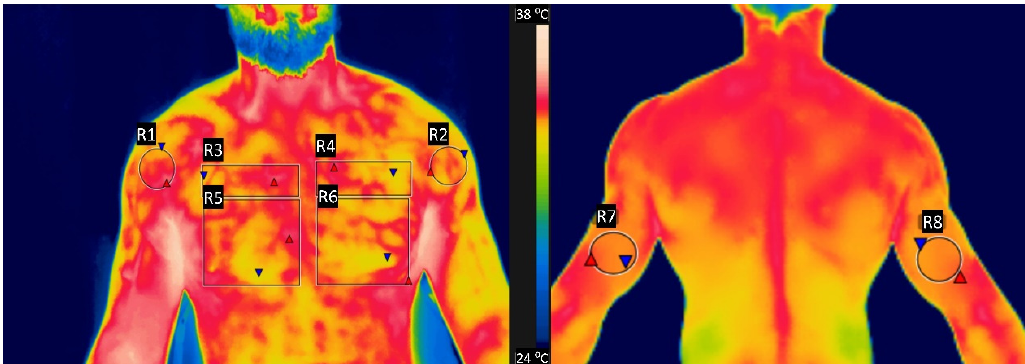
Figure 2. Illustration of the eight regions of interest (R) in the thermal images acquired (R1 and R2: Anterior Deltoid; R3 and R4: Pectoral Clavicular; R5 and R6: Pectoral Sternal; and R7 and R8: Triceps). The evaluations were carried out with data from the dominant side.